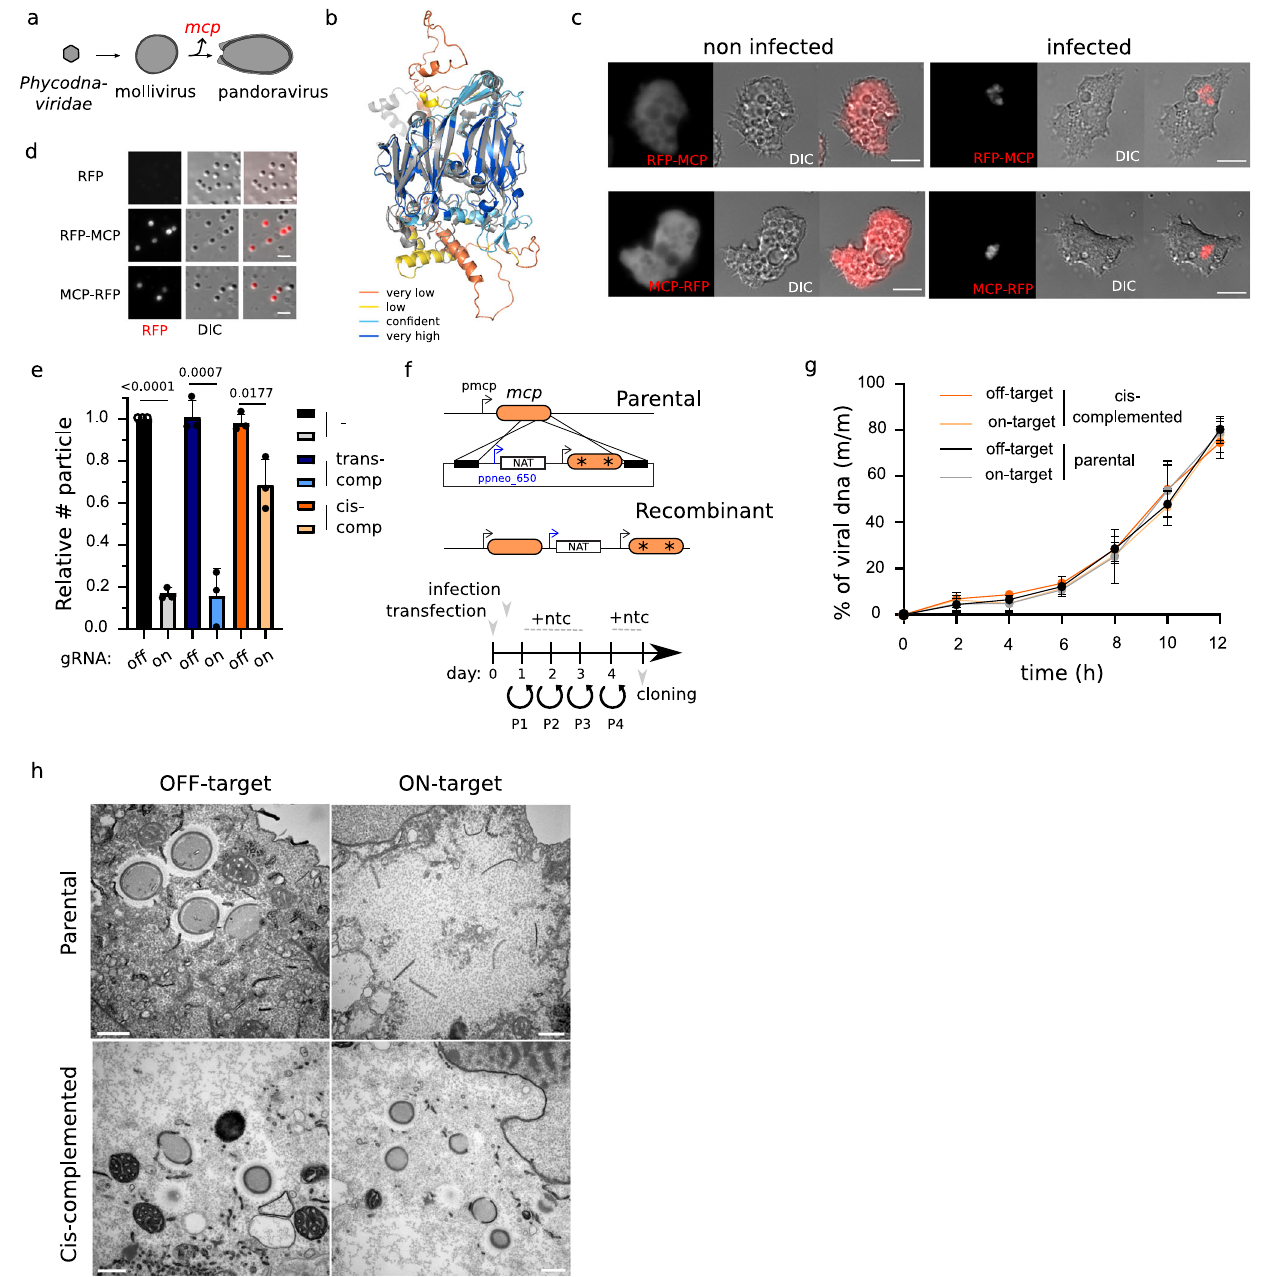
Fig.8 |MollivirusMCPactsasascaffoldingproteinfortegumentbiosynthesis. a Schematicdepictionoftheproposedmodelofevolutionforpandoravirus.Major capsid protein loss is indicated by a red color. b Alignment of the AlphaFold pre- diction of the mollivirus major capsid protein (mcp, ms_334) and the crystal structure of the PBCV-1 mcp (5TIQ). PBCV-1 mcp is shown in gray while mollivirus mcp is colored by its con fi dence score (pLDDT): Very low (0<pLDDT<50), low (50<pLDDT<70), con fi dent (70<pLDDT<90) and high (90<pLDDT<100). c Light fl uorescencemicroscopyimagesof A.castellanii cellsexpressingN-orC-terminally RFP tagged MCP. Representative images of non-infected cells and cells infected with mollivirus are shown. Images were obtained 6 hpi. Scale bar: 10 μ m. d Light fl uorescence microscopy images of mollivirus produced in A. castellanii cells expressing RFP or N- or C-terminally RFP tagged MCP. Scale bar: 1 μ